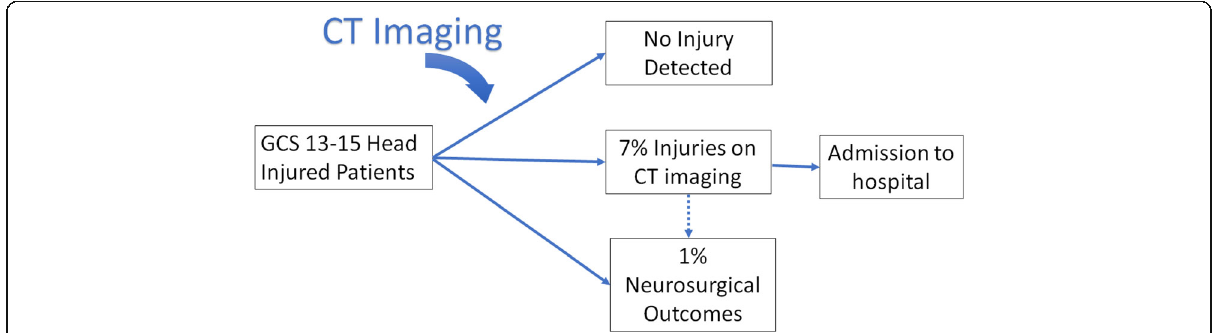
Fig. 1 Current management of minor head injured